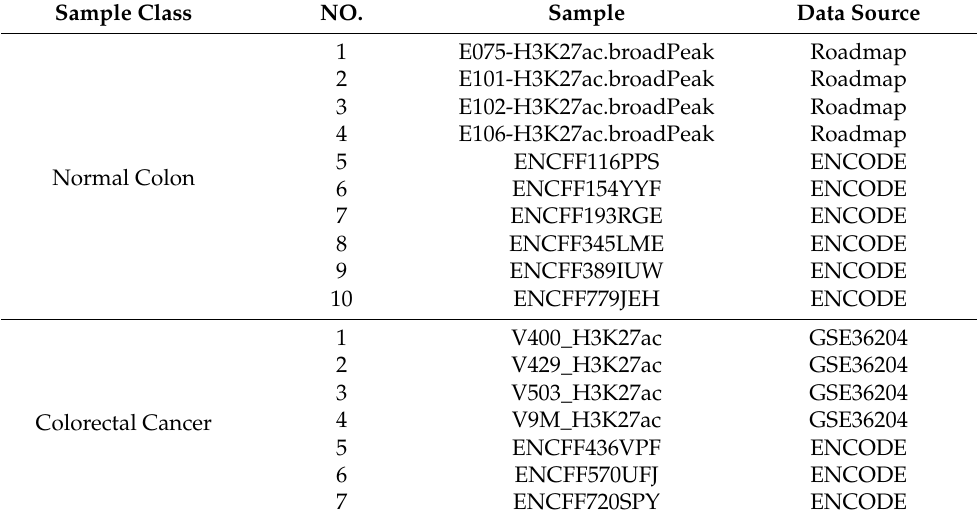
Table 1. ChIP-seq data